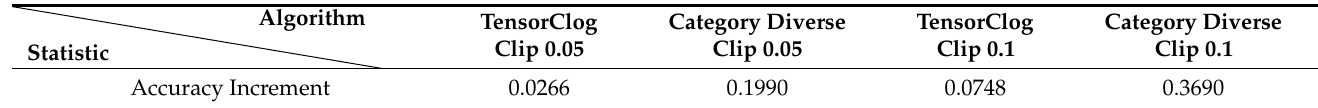
Table 6. Accuracy improvements obtained by Data Washing algorithm for TensorClog and Category Diverse paralysis attacks.